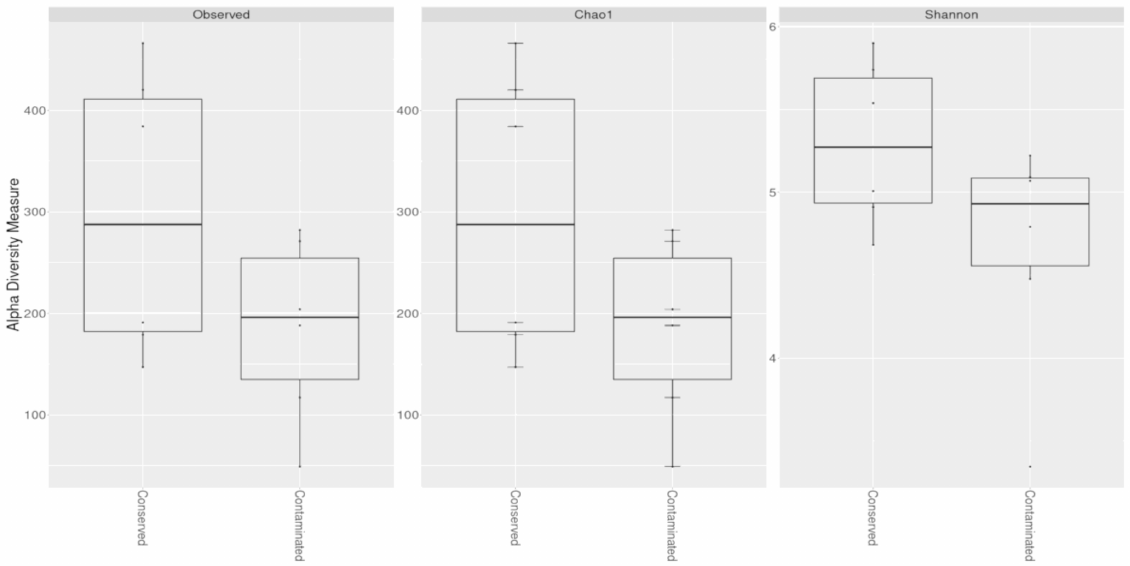
Figure 2. Alpha diversity measures of the microbial communities of conserved sites (Bocas de Dzilam and El Palmar) and contaminated sites (Progreso and Sisal). Left: Observed diversity; Center: Chao 1 estimator diversity, the bar shows the standard error of the estimator; Right: Shannon index diversity. X-axis: Analyzed environments. Y-axis: Alpha diversity measure.